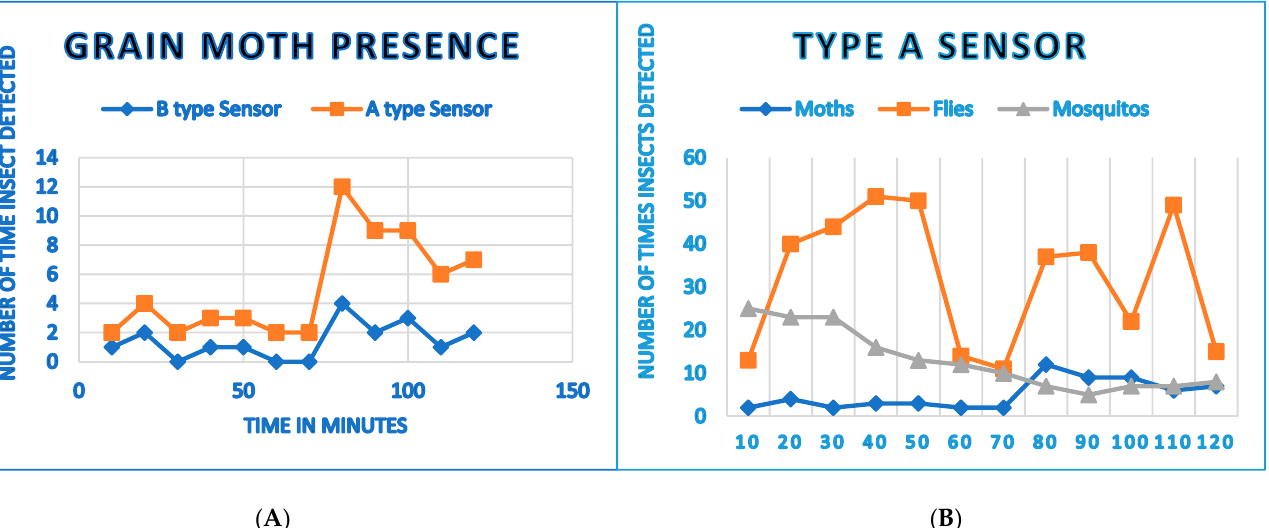
Figure 7. ( A ) Grain moths detected in the transparent box every 10 min. ( B ) Three types of insect detection through an A-type